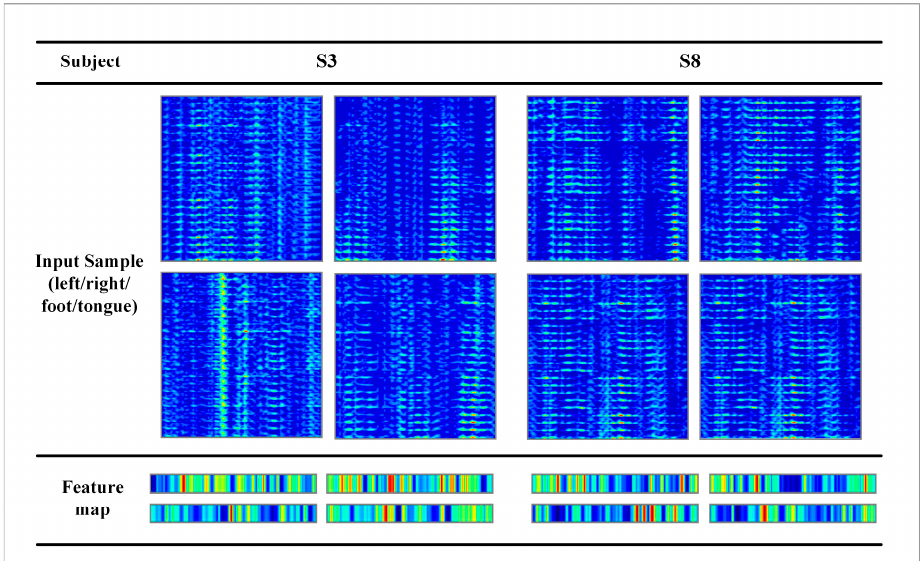
Figure 9. Visualization of the feature maps of randomly selected subjects.